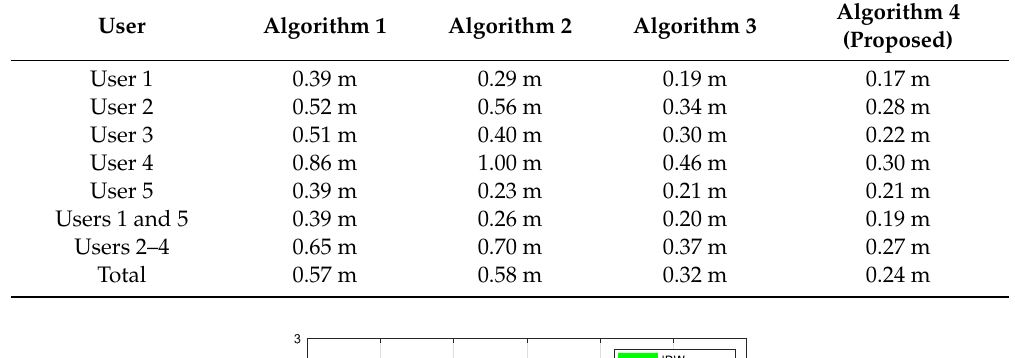
Figure 12. Probability distribution function (PDF) for the residual error of each algorithm (real data, 1 September 2014).